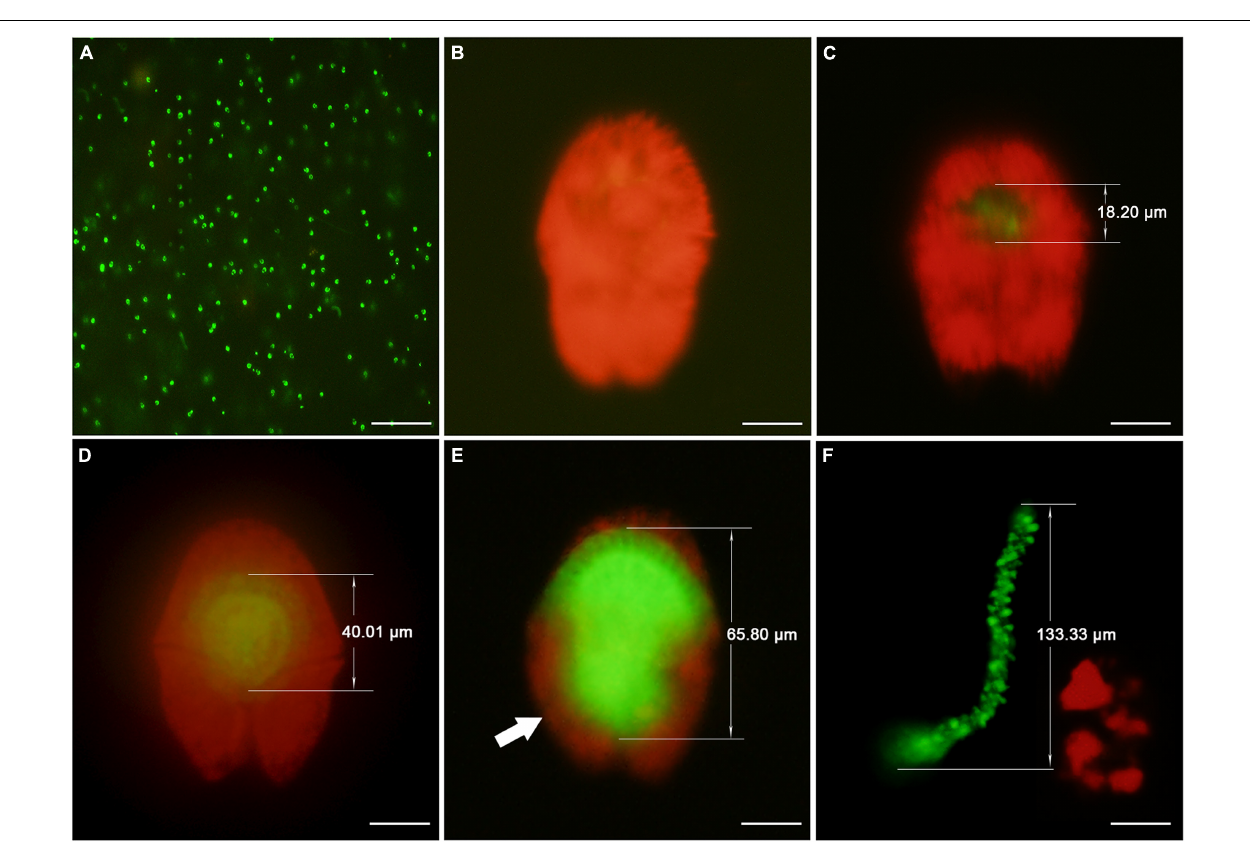
FIGURE 2 | Epifluorescence micrographs of free-swimming dinospores and Amoebophrya sp. within Akashiwo sanguinea . Amoebophrya sp. exhibited green autofluorescence throughout its life cycle and A. sanguinea showed red fluorescence under the blue light excitation. (A) Free-living dinospores of Amoebophrya sp. (B) Uninfected A. sanguinea . (C) Twelve hours infection showing a very early trophont surrounded by the red fluorescing chloroplasts of A. sanguinea . (D) Thirty hours infection showing a mid trophont surrounded by the red fluorescing chloroplasts of A. sanguinea and took on a “beehive” appearance. (E) Fifty-four hour infection showing a mature trophont and the parasites filled almost the entire host cell; the remnants of the host chloroplasts (arrow) were also shown. (F) Seventy hours infection showing a free-swimming Amoebophrya sp. vermiform and the remaining host cell fragments. Scale bars = 20 µ